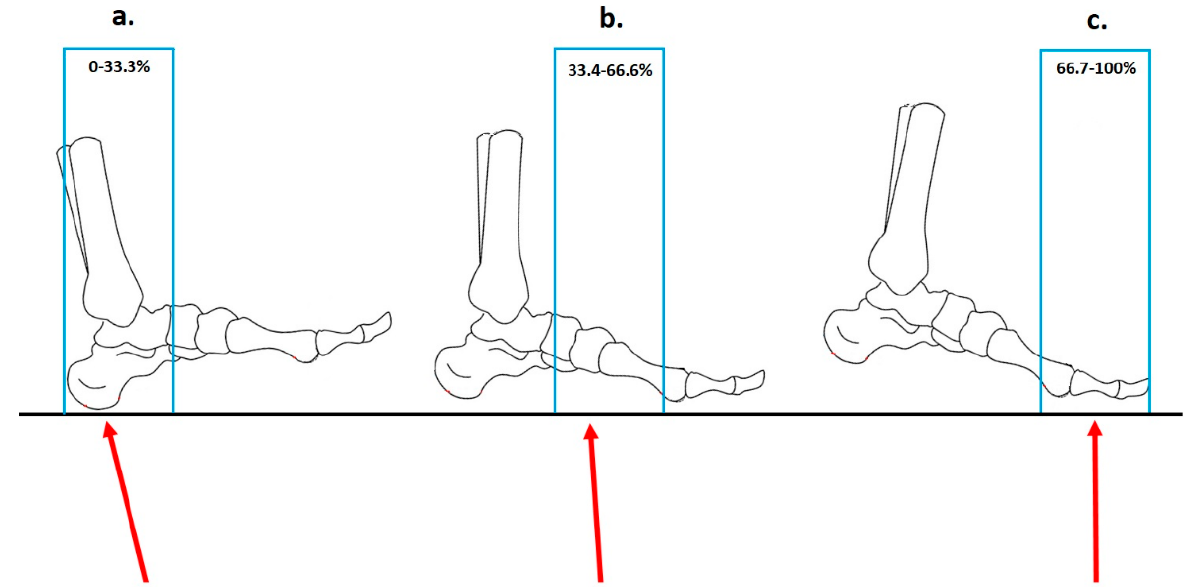
Figure 2. Definitions of footstrike modalities according to the strike index [39] ( a ) Rearfoot strike; ( b ) midfoot strike; and ( c ) forefoot strike.